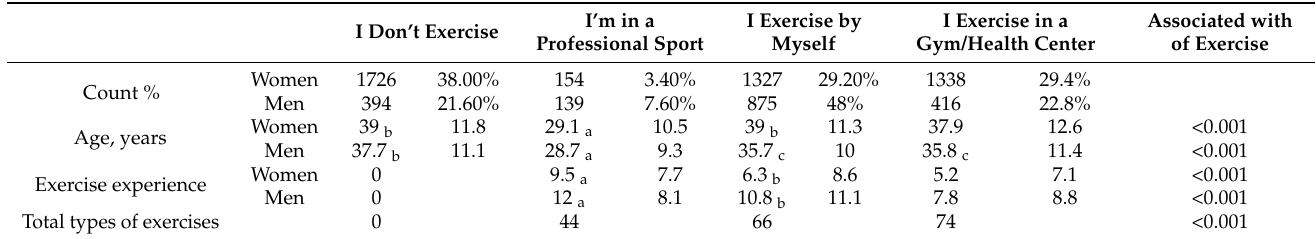
Table 1. Number, age, and exercise experience of the study participants.